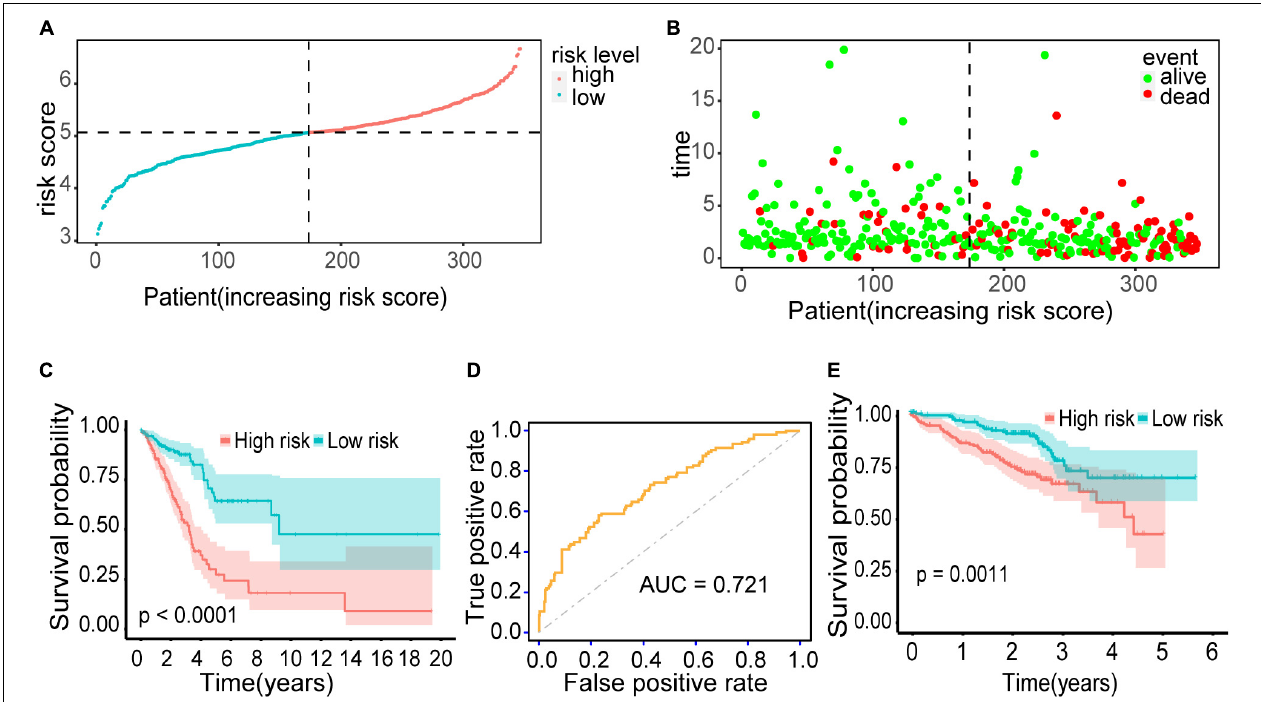
FIGURE 6 | Outcomes of the prediction model. (A) The distribution of risk scores for 345 early-stage LUAD patients. (B) The distribution of survival status, sorted by risk score. (C) Kaplan–Meier survival curve. It demonstrated the survival difference between the high-risk group and low-risk group. (D) ROC curve. It showed the performance of the model. (E) Kaplan–Meier survival curve using the validation cohort. Patients with higher risk score exhibited worse overall